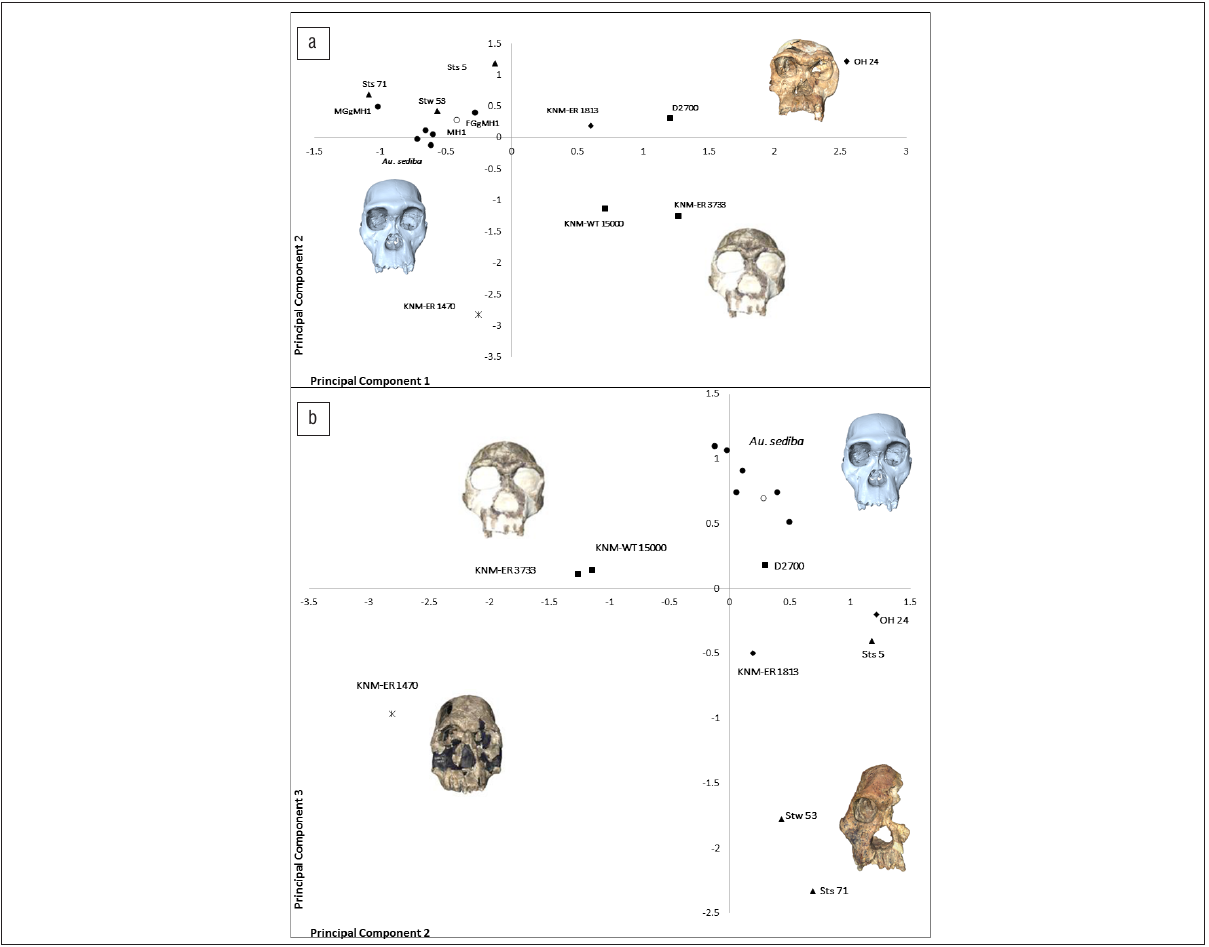
Australopithecus africanus (filled triangles); A. sediba simulated adults (filled circles); MH1 juvenile (open circle); Homo habilis (filled diamonds); H. rudolfensis (star); H. erectus (filled squares). MGgMH1 indicates the adult A. sediba specimen generated from the male gorilla developmental vector; FGgMH1 indicates the adult A. sediba specimen generated from the female gorilla developmental vector. Figure 5: Major (principal component) axes of cranial shape for non-robust fossil crania. (a) Principal components 1 (28.3% of variance) and 2 (21.7% of variance). (b) Principal components 2 and 3 (15.2% of